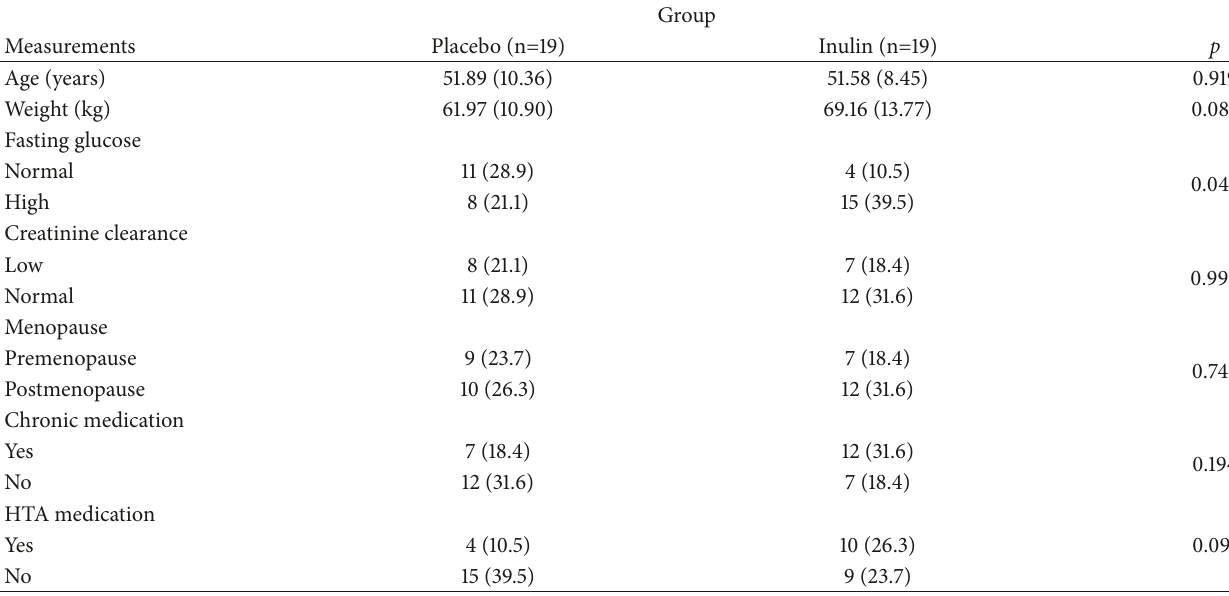
Figure 1: Study design and sample collection. Table 1: Baseline characteristics of women by study